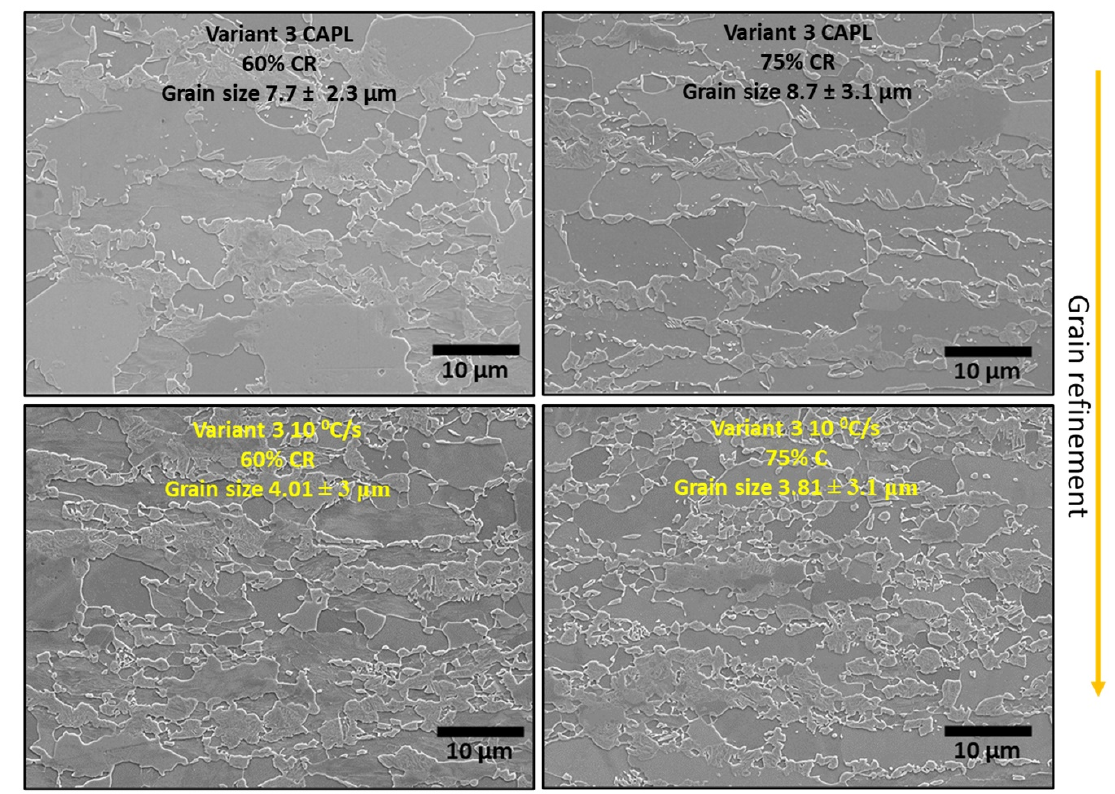
Figure 14. SEM microstructures of the cold rolled 60% and 75% Variant 3 samples inter-critically annealed using a heating rate of 1.2 °C/s and a higher heating rate of 10 °C/s.